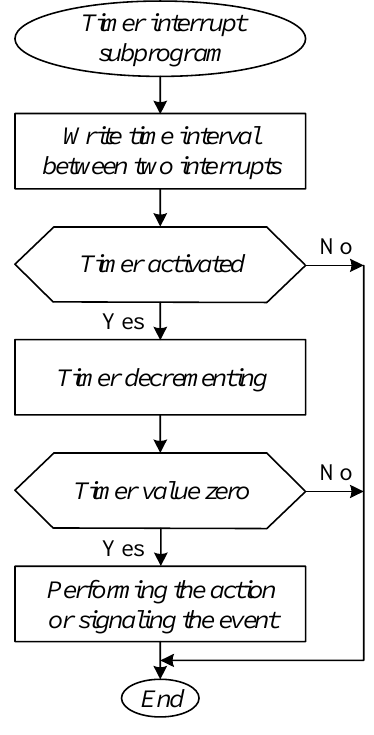
Figure 8. Timer interrupt subprogram.